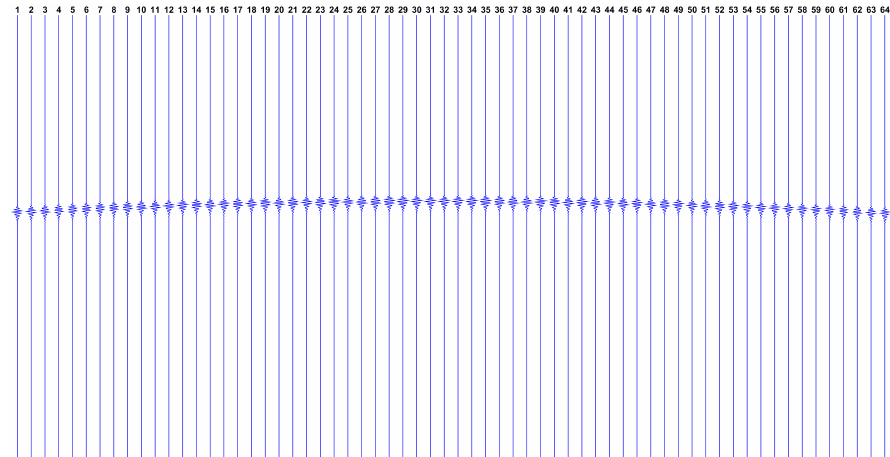
Figure 2. Expected dataset g from the transducers array, with a single reflector phantom at the region of interest (ROI) center. Each vertical line represents the dataset g n from a single transducer, over time t i (increasing from top to bottom).